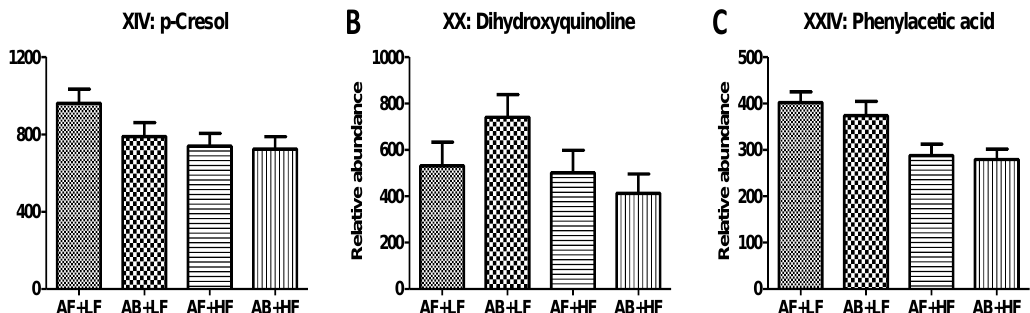
Figure 4. Effects of antibiotic and fiber treatments on microbial metabolites of aromatic amino acids in feces. ( A ) p -Cresol, ( B ) 4,6-dihydroxyquinoline, ( C ) phenylacetic acid. p- values are presented in